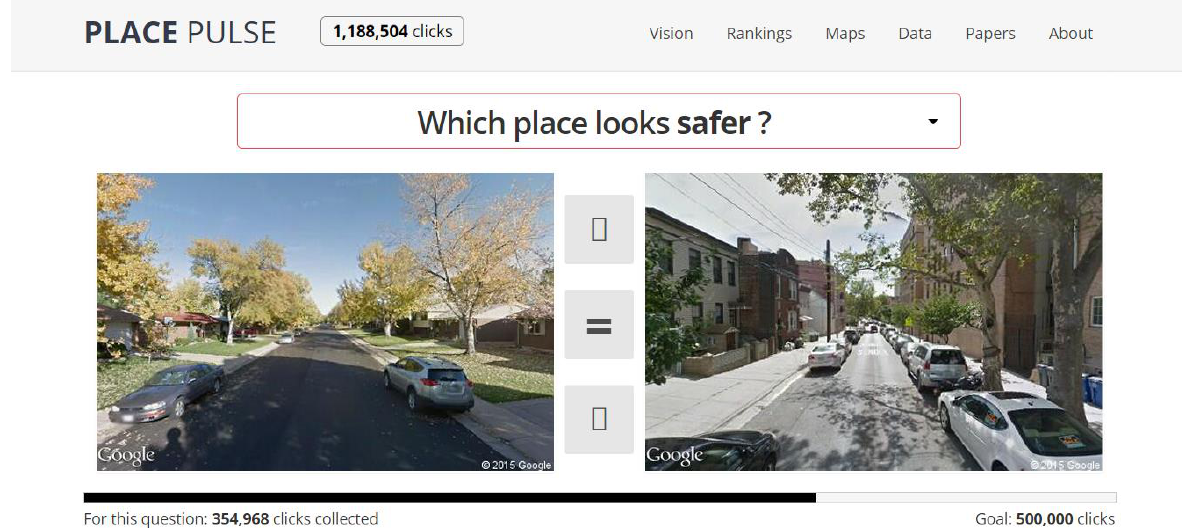
Figure 1. Website for Place Pulse data collection.